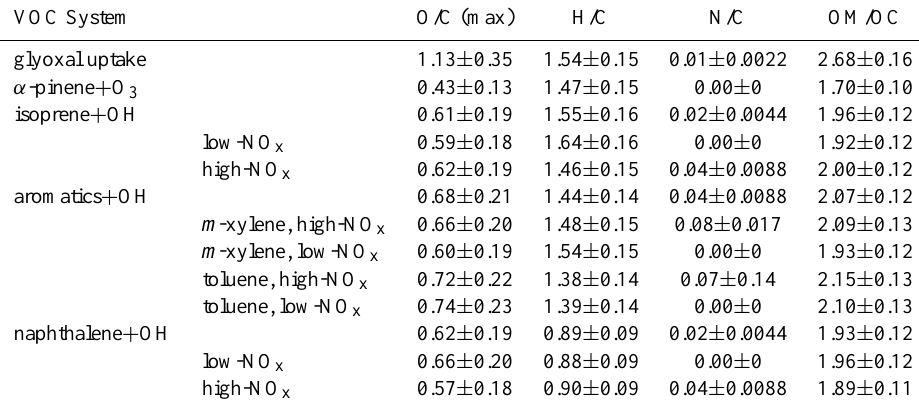
Table 2. Elemental composition of each SOA system. Values represent the average ratio for each experiment at the time of maximum O/C. Uncertainty estimates reflect the measurement uncertainty as determined by Aiken et al.